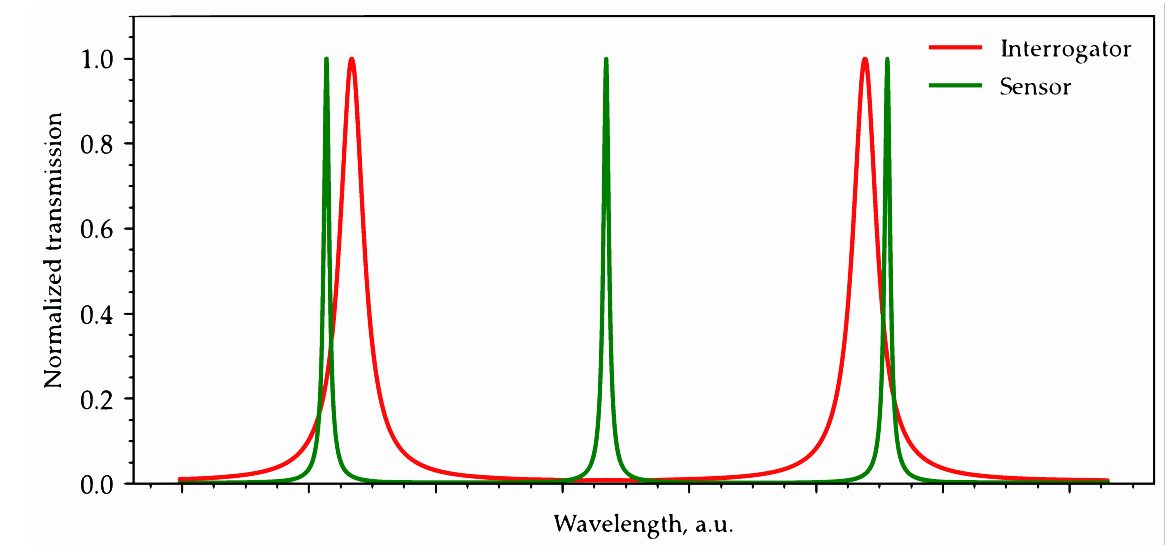
Figure 3. An example of improper overlapping of the interrogator and sensor transmission spectra, which can lead to destructive crosstalk between signals from two sensors’ resonant peaks.